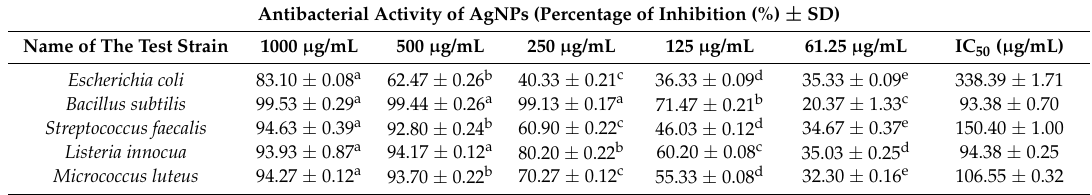
Table 4. Antimicrobial activity of AgNPs by micro broth dilution